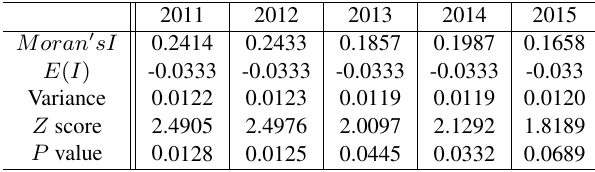
Table 1. The result of global Moran’s